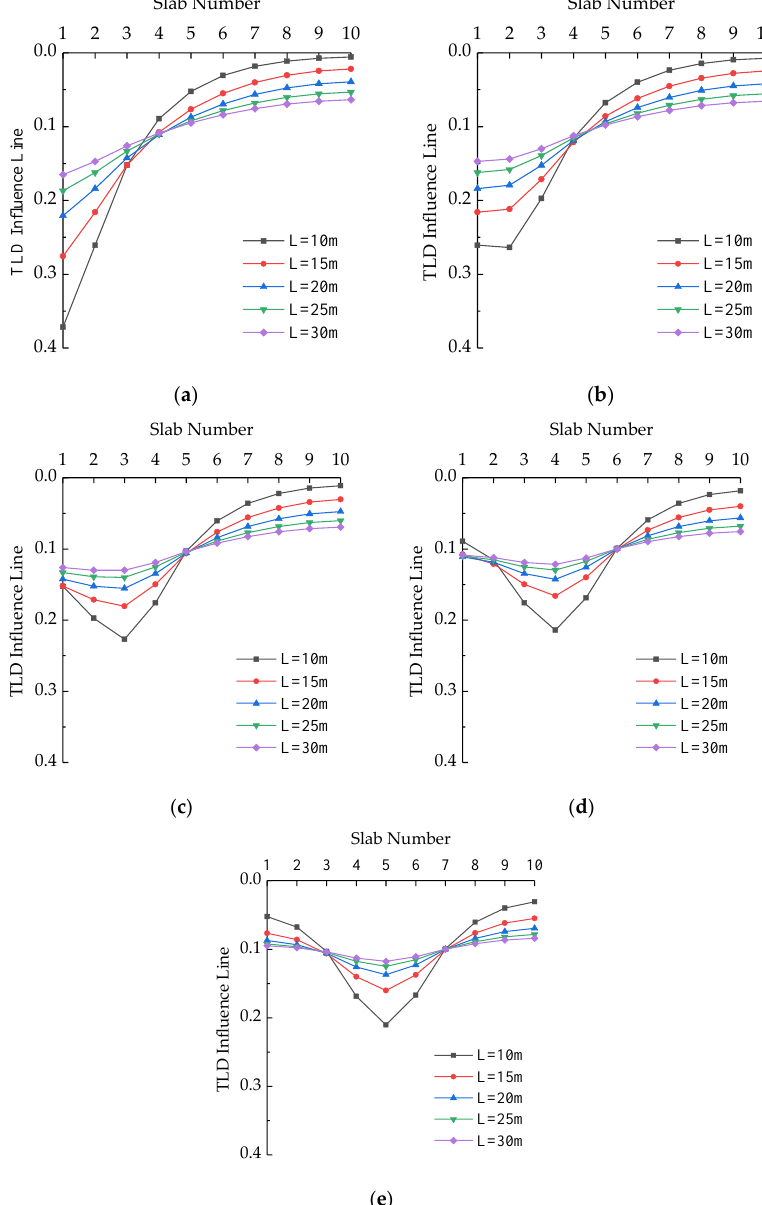
Figure 13. The TLD influence lines of each slab at different spans: ( a ) slab 1; ( b ) slab 2; ( c ) slab 3; ( d ) slab 4; ( e ) slab 5.